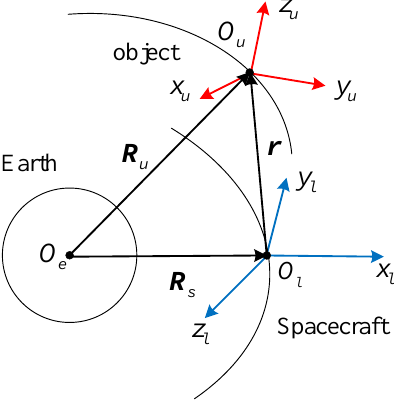
Figure 2. The relative motion of the tracking spacecraft and the